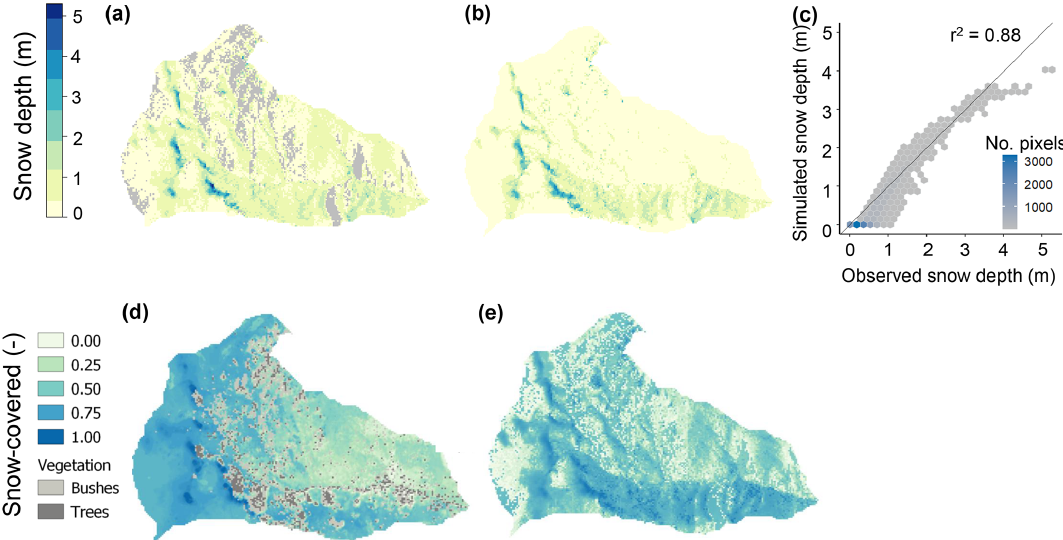
Figure 2. (a) Lidar snow depth (m) at 3m resolution on 18 March 2009 and (b) simulated snow depths for the same day, where yellow indicates low snow depths, blue indicates high snow depths, and gray indicates the areas for which the snow depth could not reliably be determined from the lidar measurement (see Sect. 3.2). (c) Hexagonal bin plot comparing the observed and simulated snow depths, with gray colors indicating fewer pixels and blue indicating more pixels included per bin. (d) The fraction of images for which sites were snow covered, using 3m resolution satellite imagery for the available images ( n = 41) of water year 2019 (see Sect. 3.2), and (e) the fraction of time during which each pixel was snow covered, using the simulated snow cover from the beginning of water year 2009 until all snow had melted ( n = 238). Bushes and trees (marked in gray in panel d ) inhibited the exact determination of the snow cover for the satellite imagery in some locations.